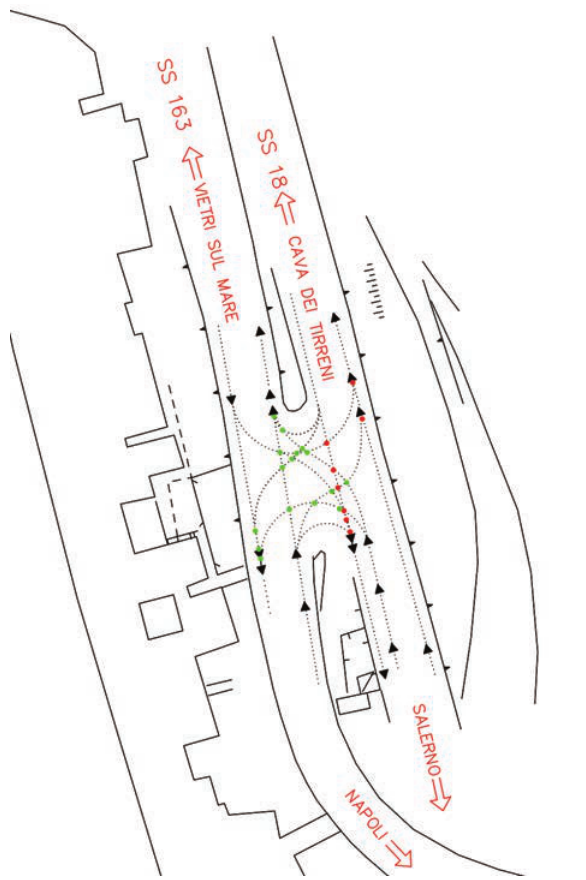
Fig. 2. Manoeuvres and points of conflict